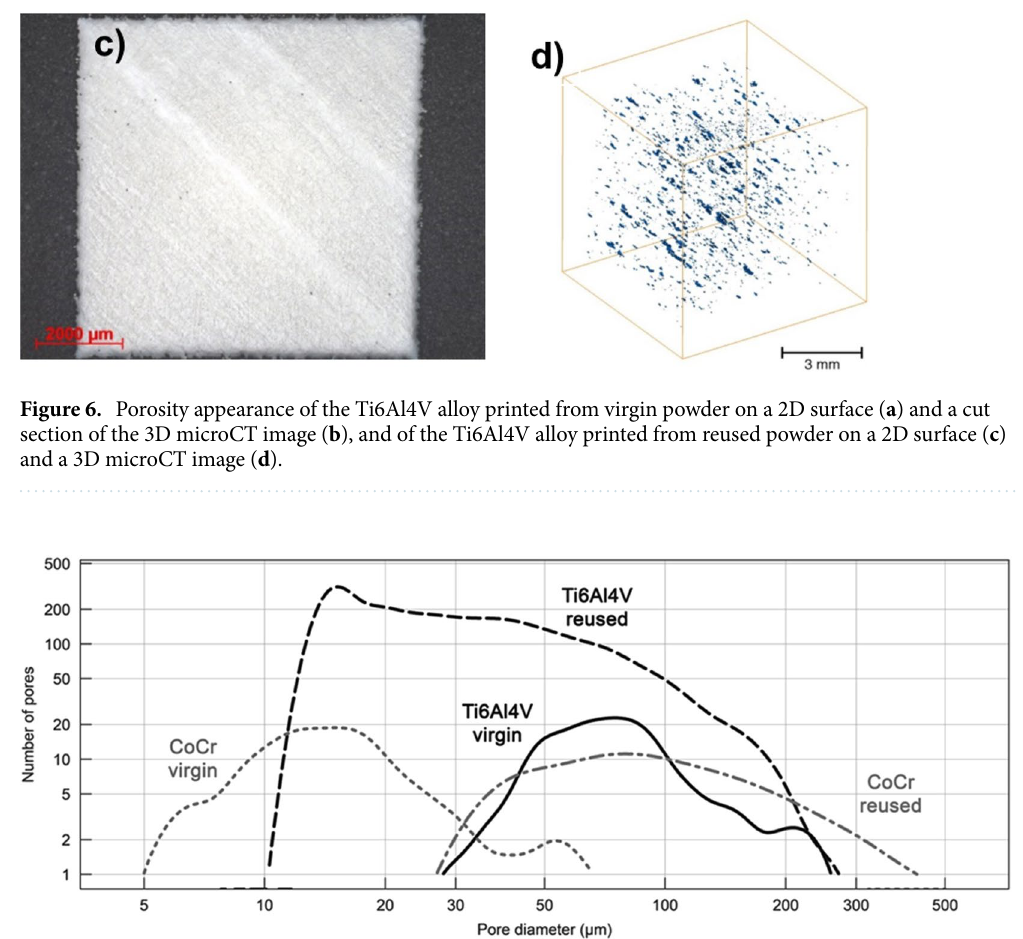
Figure 7. Comparison of pore diameter distribution for CoCr and Ti6Al4V alloys made from virgin and reused powder, represented as the total number of pores. Pore diameter distribution for the virgin CoCr material is not shown as no pores were detected through microtomographic